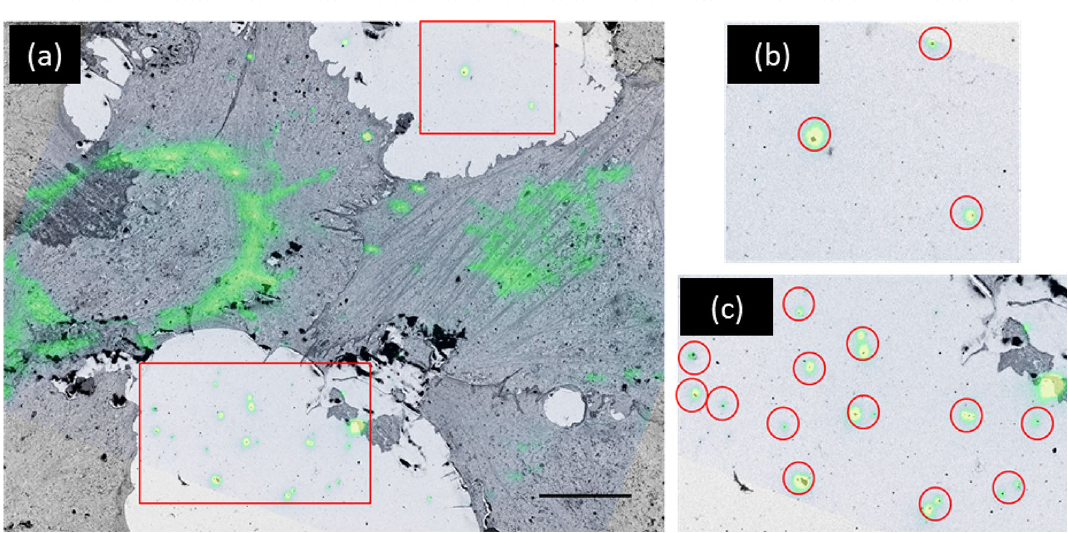
Figure 5. Overlaid iPALM 2D projection fluorescence image and SEM image used for coarse co-registration. Gold nanorods are visible in both imaging modalities as shown in ( a ). Higher magnification images of the two highlighted regions of fiducials are shown in ( b ) and ( c ). The broad area of OSSM ensures many fiducials may be used for correlation. Scale bar in ( a ) is 10